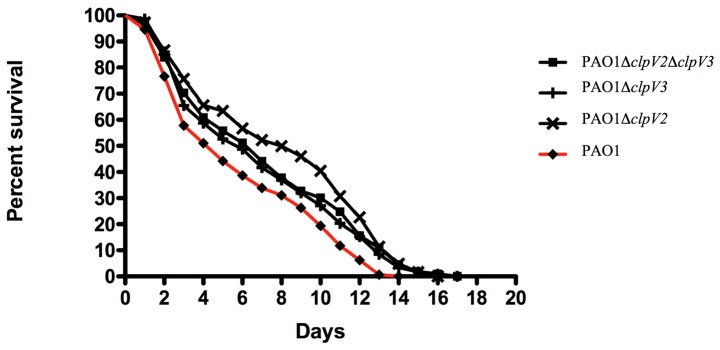
H3-T6SS is required for virulence in C. elegans.
C. elegans was infected with PAO1 and isogenic ΔclpV2, ΔclpV3 or ΔclpV2ΔclpV
3 mutants. The resulting C. elegans survival curve is shown for each strain. Evalue <0.01 (Prism 5 software).